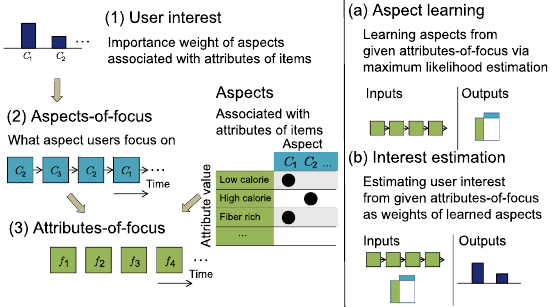
Figure 4. Illustration of interest-driven attention focusing